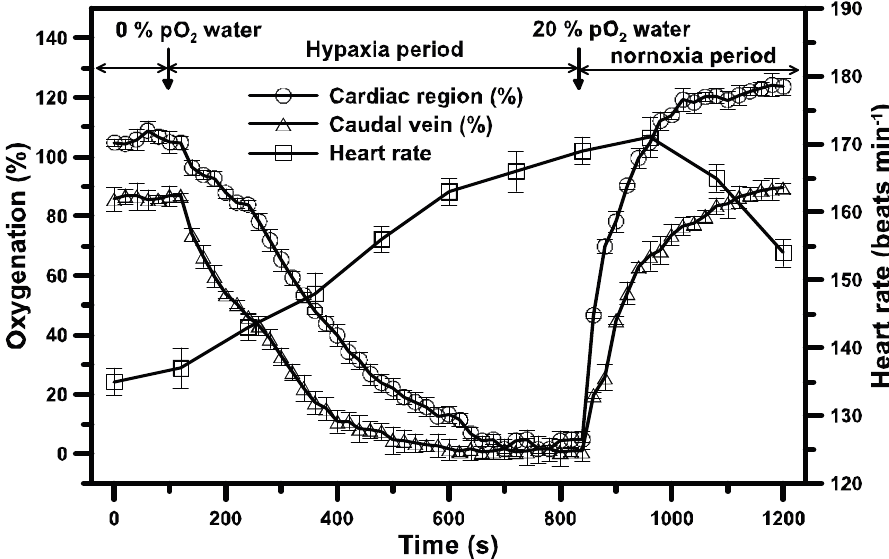
Figure 8. The time variation of the heart rate (beats min − 1 ) and in vivo oxygen changes (%) in C.R. and C.V. of a 48 hpf zebrafish embryo that experience hypoxia (0% pO 2 ) and subsequent normoxic conditions (20% pO 2 ) by sequentially perfusing normoxic/hypoxic/ normoxic medium into a microfluidic